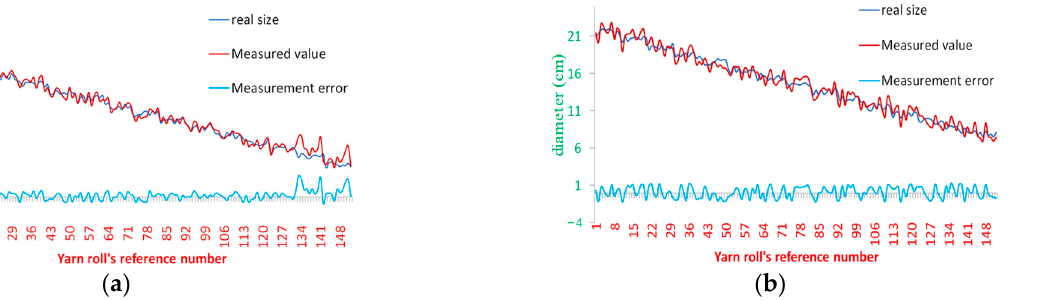
Figure 14. Yarn roll’s diameter measurement error. ( a ) Conic yarn roll. ( b ) Cylindrical yarn roll.